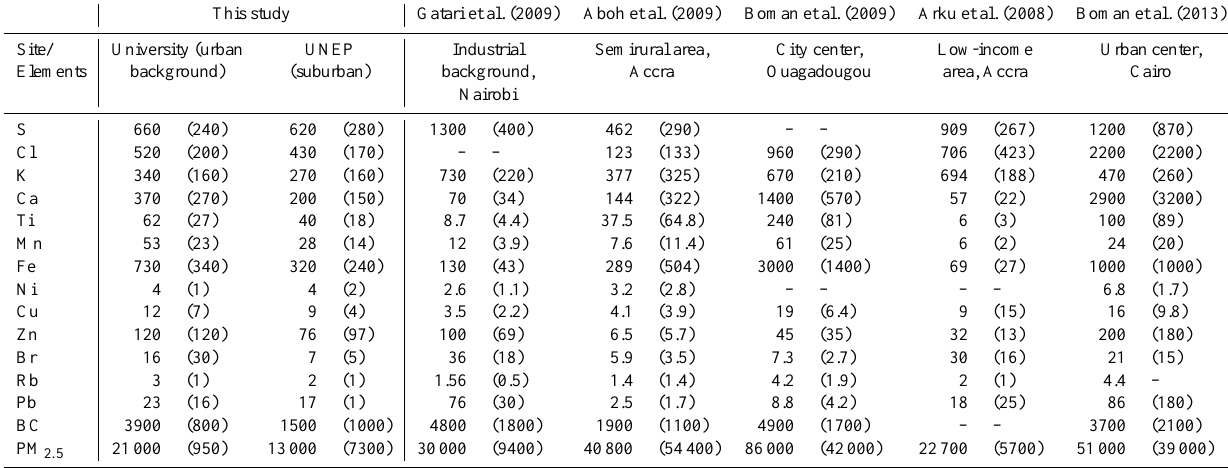
Table 3. PM 2 . 5 , BC and trace element concentrations from this study (Nairobi) compared with concentration from other cities in Africa. Concentrations are in ngm − 3 . Values enclosed in brackets are the standard